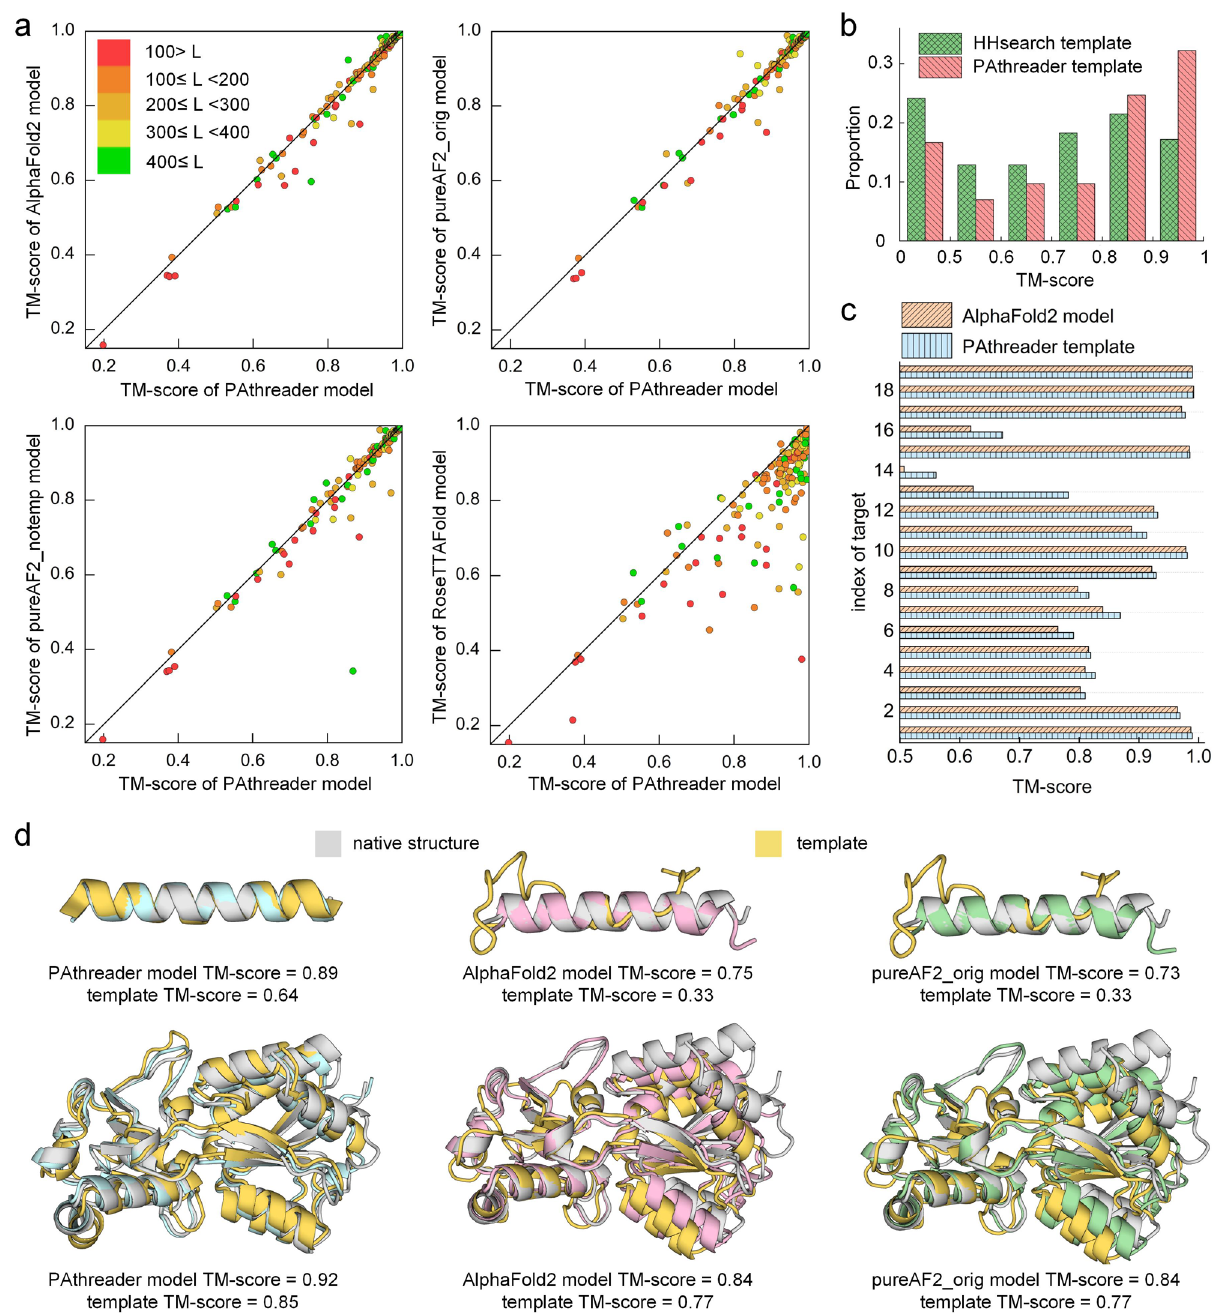
Fig. 4 Performance of PAthreader on CAMEO. a Head-to-head TM-score comparison of PAthreader with AlphaFold2, pureAF2_orig, pureAF2_notemp, and RoseTTAFold for structure modelling. Each point represents a protein target, and different colors indicate different protein sizes. b The distribution of the TM-score of templates identi fi ed by PAthreader and HHsearch. c Comparison of the TM-score of templates by PAthreader and the model obtained using AlphaFold2 on 19 proteins. d Examples of the single-domain protein 7PNO_D and the multi-domain protein 7T4Z_A. The structure superpositions of PAthreader model (blue), AlphaFold2 model (pink), and pureAF2_orig model (green) with the native structure (grey) and template (yellow) are